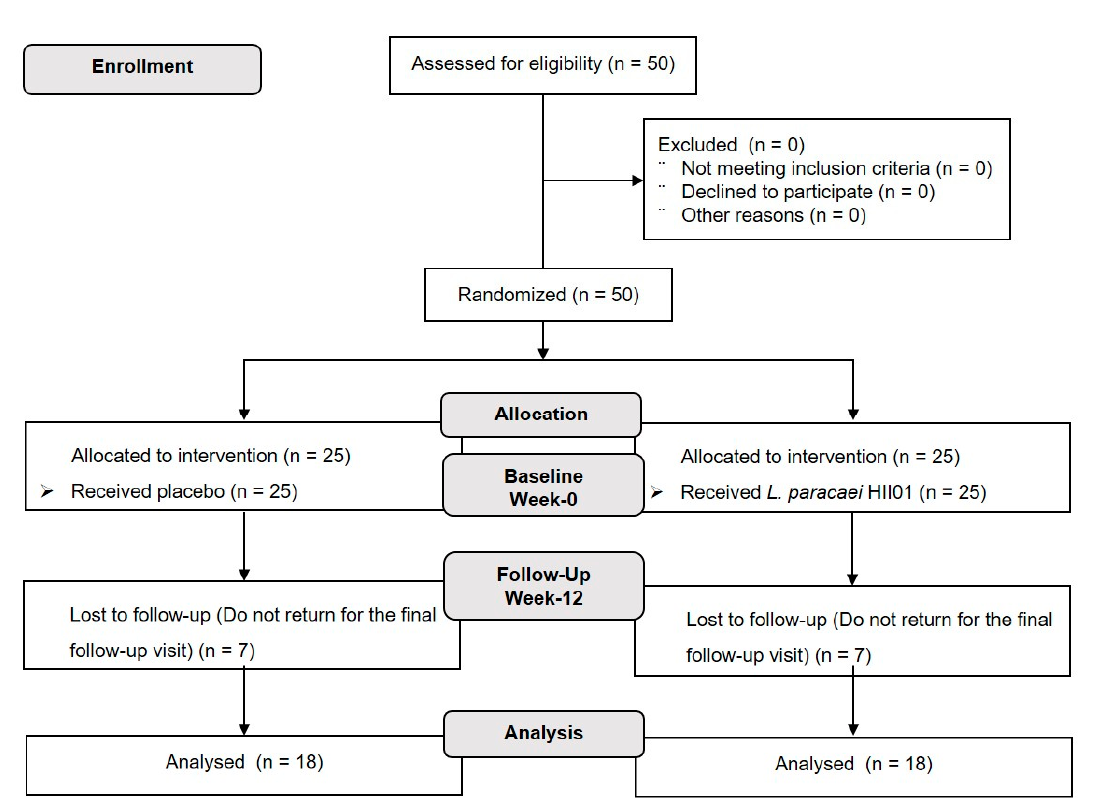
Figure 1. Flowchart of the study design.